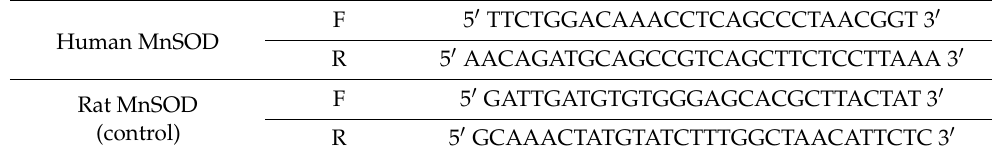
Table 1. Primer sequences for detection of human and rat MnSOD genes after hMnSOD gene